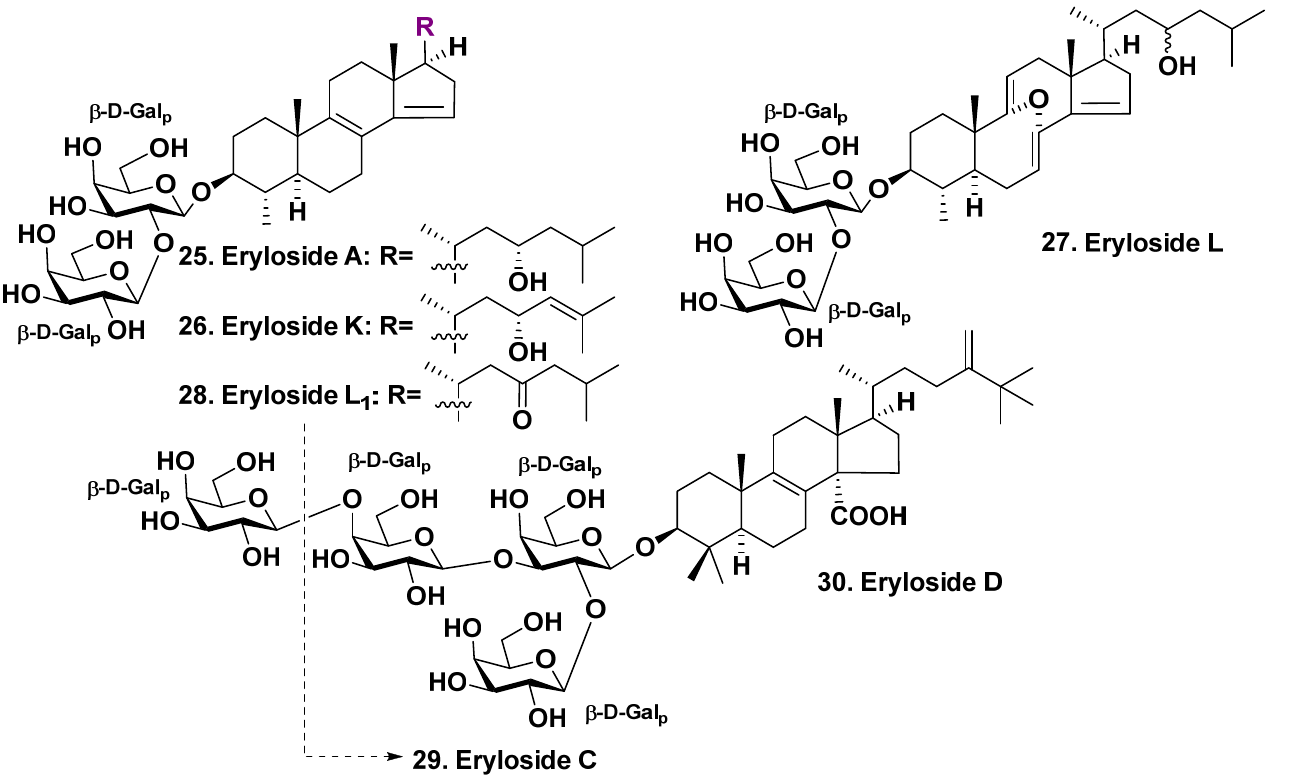
Figure 2. Erylosides 25 – 28 from Erylus lendenfeldi and erylosides 29 , 30 from Erylus sp. Almost simultaneously, Sandler et al. [31] from Faulkner’s laboratory have isolated the same eryloside A ( 25 ) with two similar glycosides named erylosides K and L ( 26 , 28 ) from another Red Sea collection of this species. The structure of eryloside K was identical to that described by Fouad et al. [30]. The second new glycoside 28 , also called eryloside L by Sandler et al. [31], differed in structure from the compound described by Fouad et al. [30]. Eryloside L1 ( 28 ), depicted in Figure 2, contains an aglycone similar to that of erylosides A and K, as well as a 23-keto group in the side chain. The 23 S -configuration of eryloside A ( 25 ) was firstly established by Mosher’s method. The C-23 absolute configuration in 26 was assigned by comparison 1 H NMR spectra, HPLC retention times, and optical rotation derivatives of 25 and 26 obtained by hydrogenation using a rhodium catalyst [31]. Glycoside 25 reveals antifungal action on Candida albicans (MIC of 15.6 µ g/mL) and cytotoxicity on P388 tumor cell line (IC 50 of 4.2 µ g/mL) [30]. This glycoside is active on Bacillus subtilis, C. albicans , and Escherichia coli (zones of inhibition at 10 µ g per disc were of 7, 7, and 6 mm, respectively) [30]. Glycosides 25 and 26 gave the mortality rate of